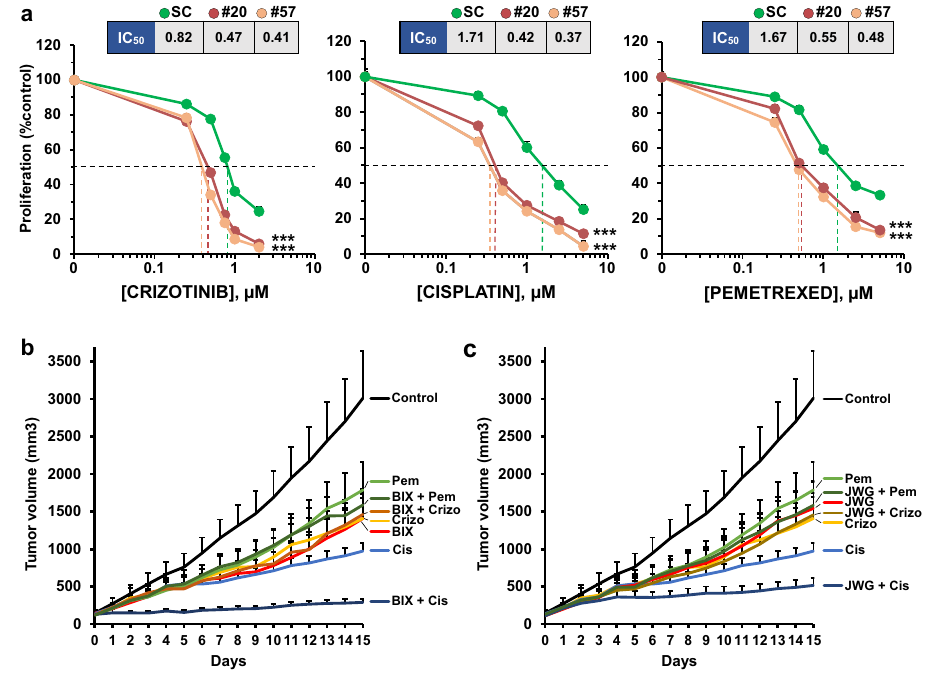
Fig. 6 MEK5/ERK5 inhibition synergizes with standard of care treatments. a H460 scramble cells and H460 ERK5 CRISPR clones (#20 and #57) were plated in 24-well dishes, and 24 h later treated with the indicated doses of standard of care agents for 48 h. Cell viability was measured by an MTT assay and each condition (scramble, #20 and #57) was represented as percentage from their respective untreated cells. Results are expressed as mean ± SD of an experiment that was repeated twice. Error bars are shown. The IC50 values and p -values for each drug and condition are also indicated (*** p ≤ 0.001). b In vivo analyses of the effect of BIX02189 and JWG-071 ( c ) alone or in combination with standard of care drugs, on the growth of H460 cells subcutaneously implanted in mice and treated with the indicated drugs as described under the “ Methods ” section. Tumor masses ( n = 8 – 10 tumors per group) were measured daily for two weeks. The mean tumor volume and SEM error bars of each group are represented. To avoid excessive overlapping of the curves, the data of the drug combination with BIX02189 or JWG-071 were split in ( b , c ). Therefore, please notice that the curves for control, pemetrexed, crizotinib or cisplatin are the same in both ( b , c ). Exact p -values of comparisons between control untreated and treated groups are shown in Supplementary Table 1e and